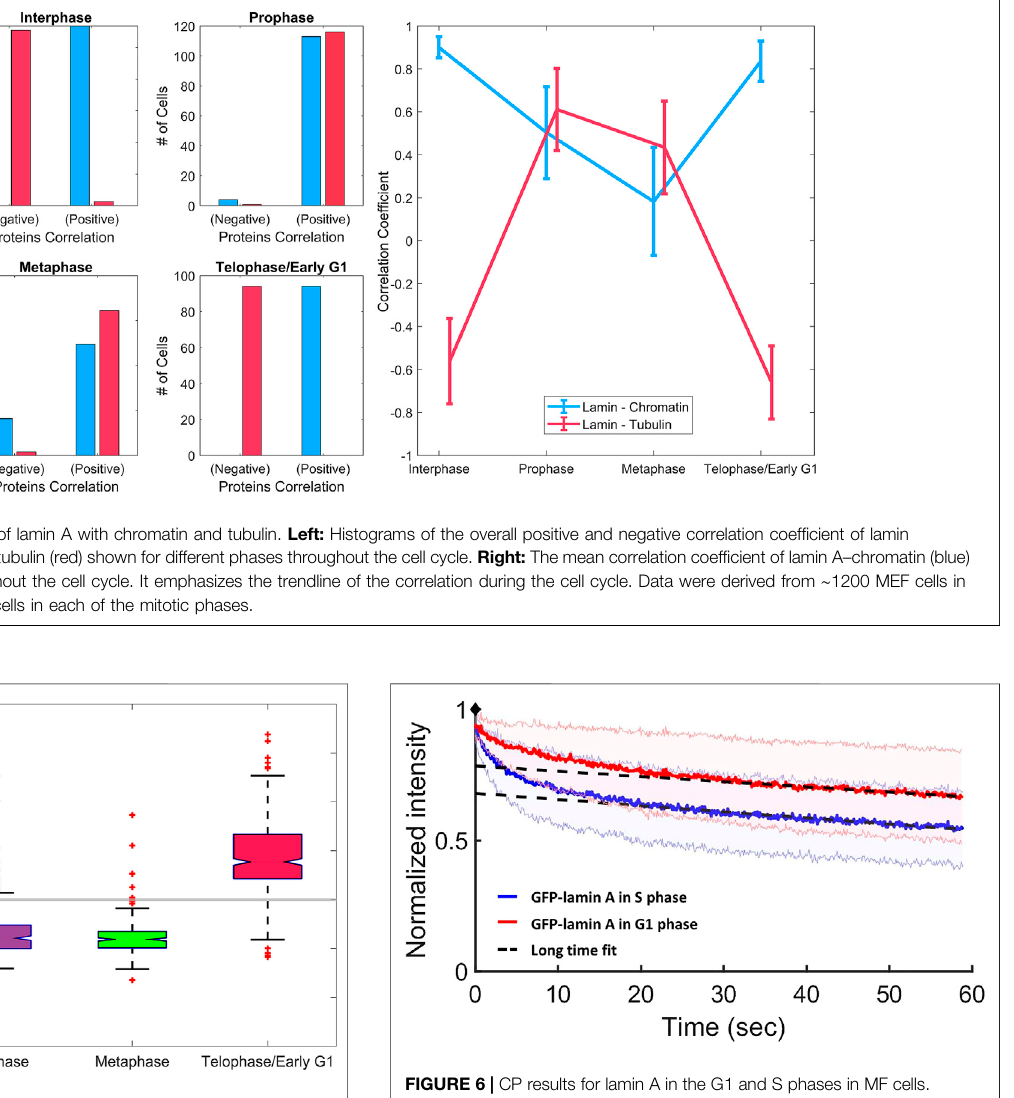
FIGURE 5 | Analysis of lamin A in the lamina. A boxplot of the intensity pro fi le of lamin A at the periphery of the nucleus, relative to the interior of the nucleus at different cell cycle stages in MEF cells. In the interphase and telophase/early G1, the relative intensity is larger than 1, whereas in prophase and metaphase, it is smaller than 1.